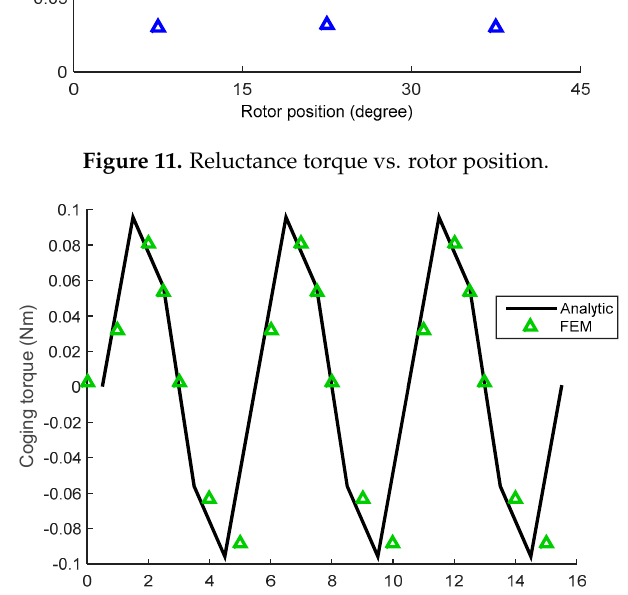
Figure 12. Cogging torque vs. rotor position.